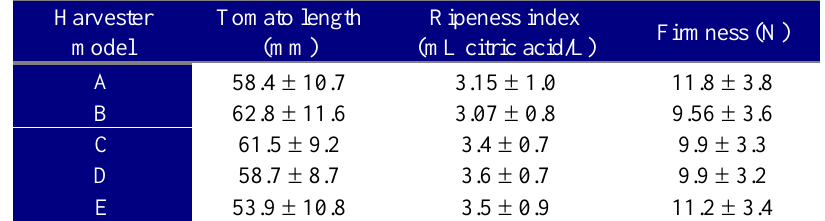
Table 3. Summary of laboratory data (mean and standard deviation): Tomato length (mm), firmness (N) and ripeness index (mL citric acid/L), for each harvester